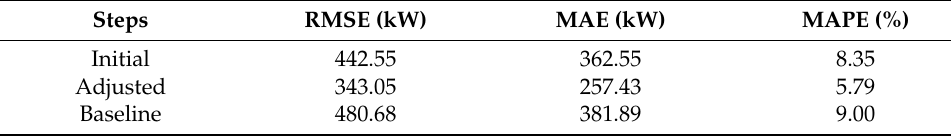
Table 13. Results of the 12-h-ahead forecasts.